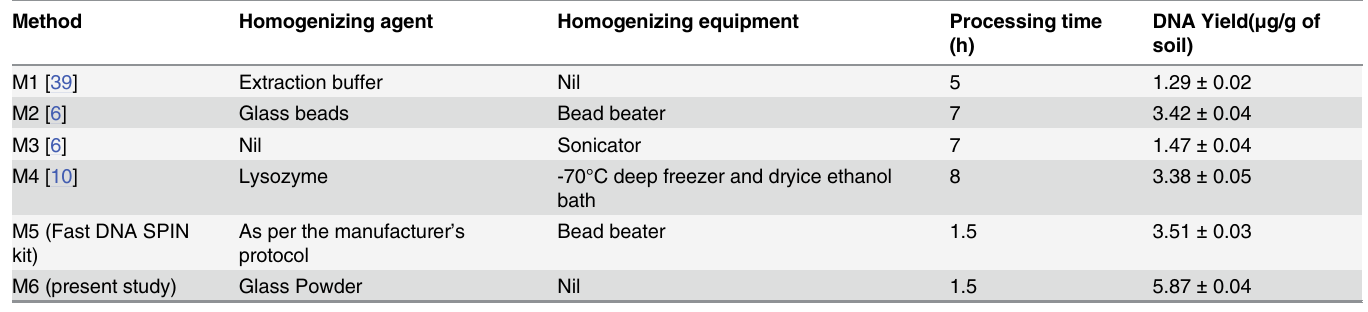
Table 1. Different methods used for extraction of metagenomic DNA from four different soils. Method Homogenizing